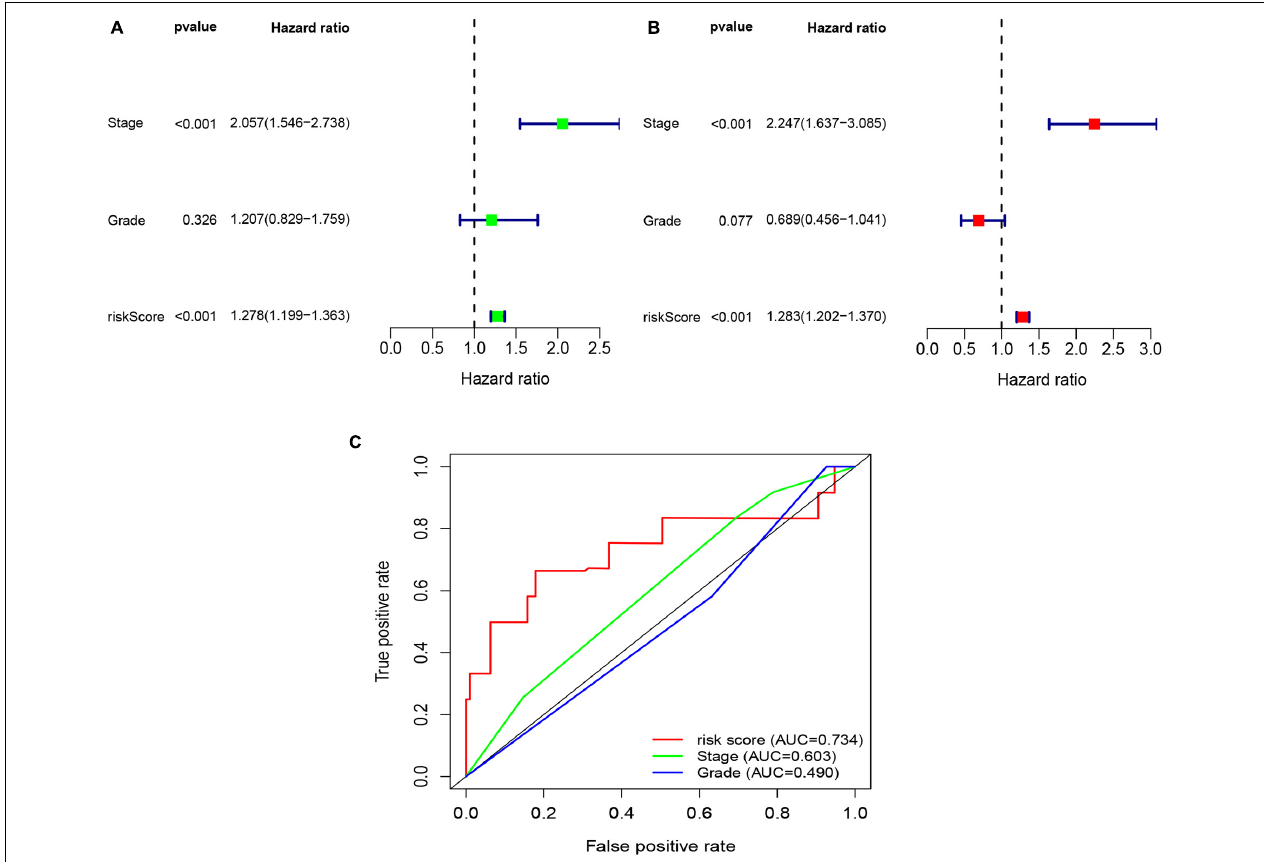
FIGURE 5 | Univariate and multivariate Cox regression analyses based on the risk score and other clinical features in the GSE26193 dataset. (A) Univariate Cox regression analyses. (B) Multivariate Cox regression analyses. (C) ROC curve analysis of the risk score and other clinical